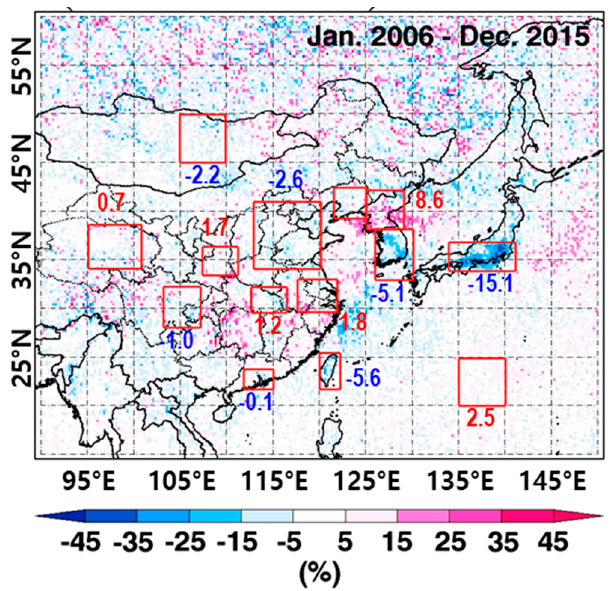
Figure 9. Spatial map of the relative differences between the NO 2 columns on the weekend ( Ω WKND ) and weekday ( Ω WKDY ) during the period 2006–2015. The blue and red numbers given in the figure represent the relative differences for the analysis regions.